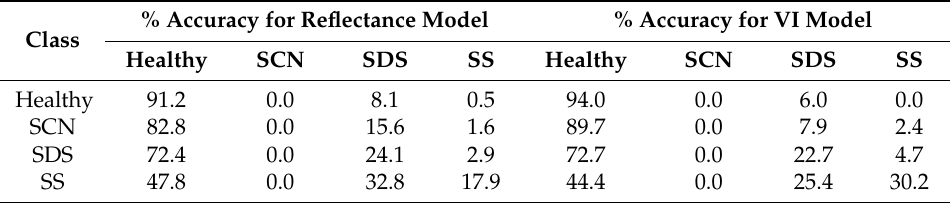
Table 7. Classification accuracy with Logistic Discriminant Model ( n = 799) developed on leaf reflectance data as well as vegetation index data using the ten best input variables. The model on VI chose GRVI, C420, TVI, SIPI, MCARI, NDVI, WDRVI, RVI, NDRE and mSR as the best input